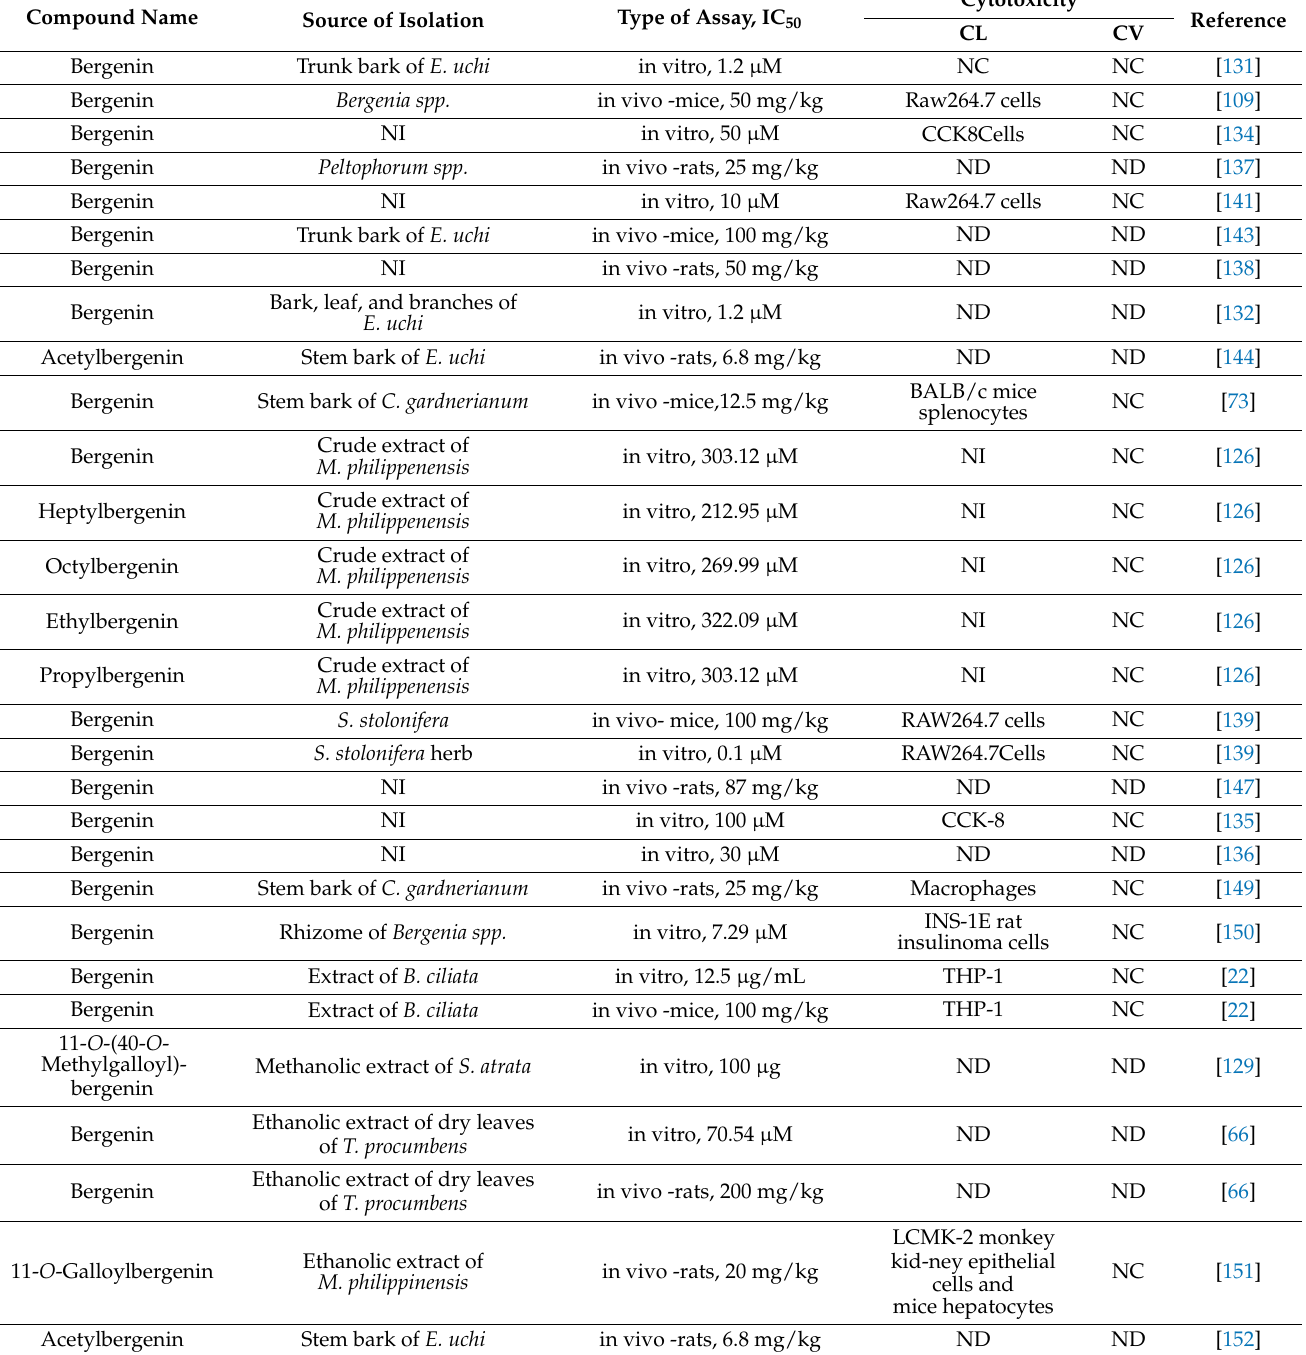
Table 3. Studies related to the anti-inflammatory activity of bergenin and its